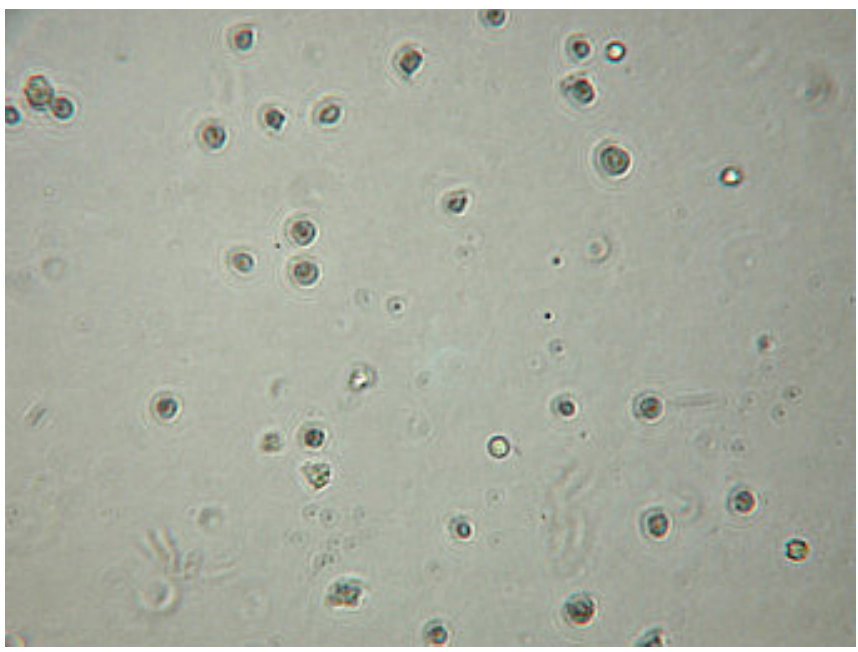
FIGURE 3 - Human fibroblasts in suspension detached from the surface of a Petri dish with spherical morphology. (100x magnification)